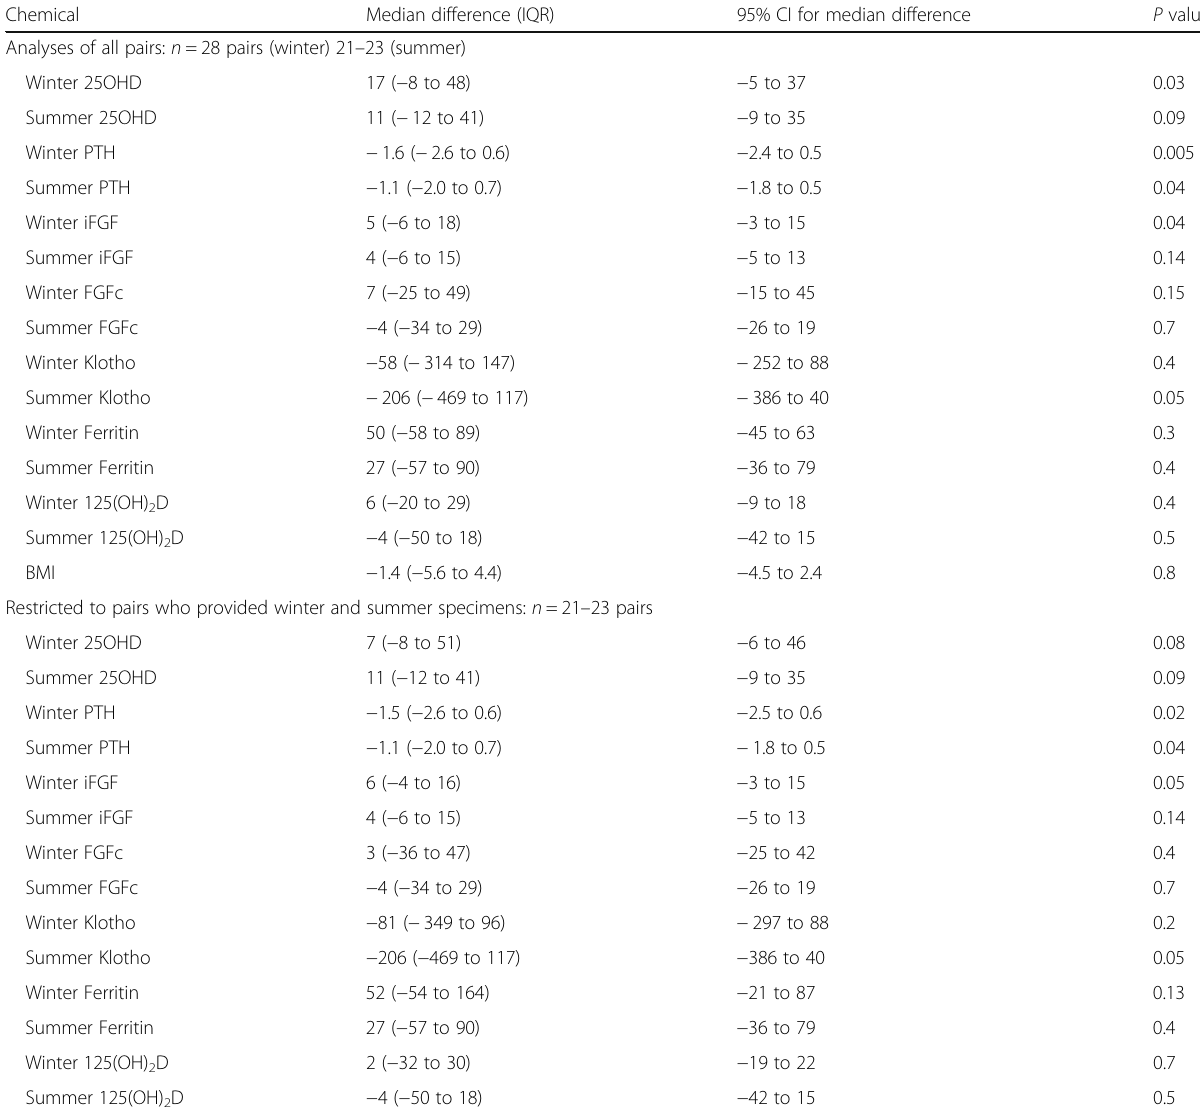
Table 2 Pairs analyses (subject with RRMS minus HC friend)